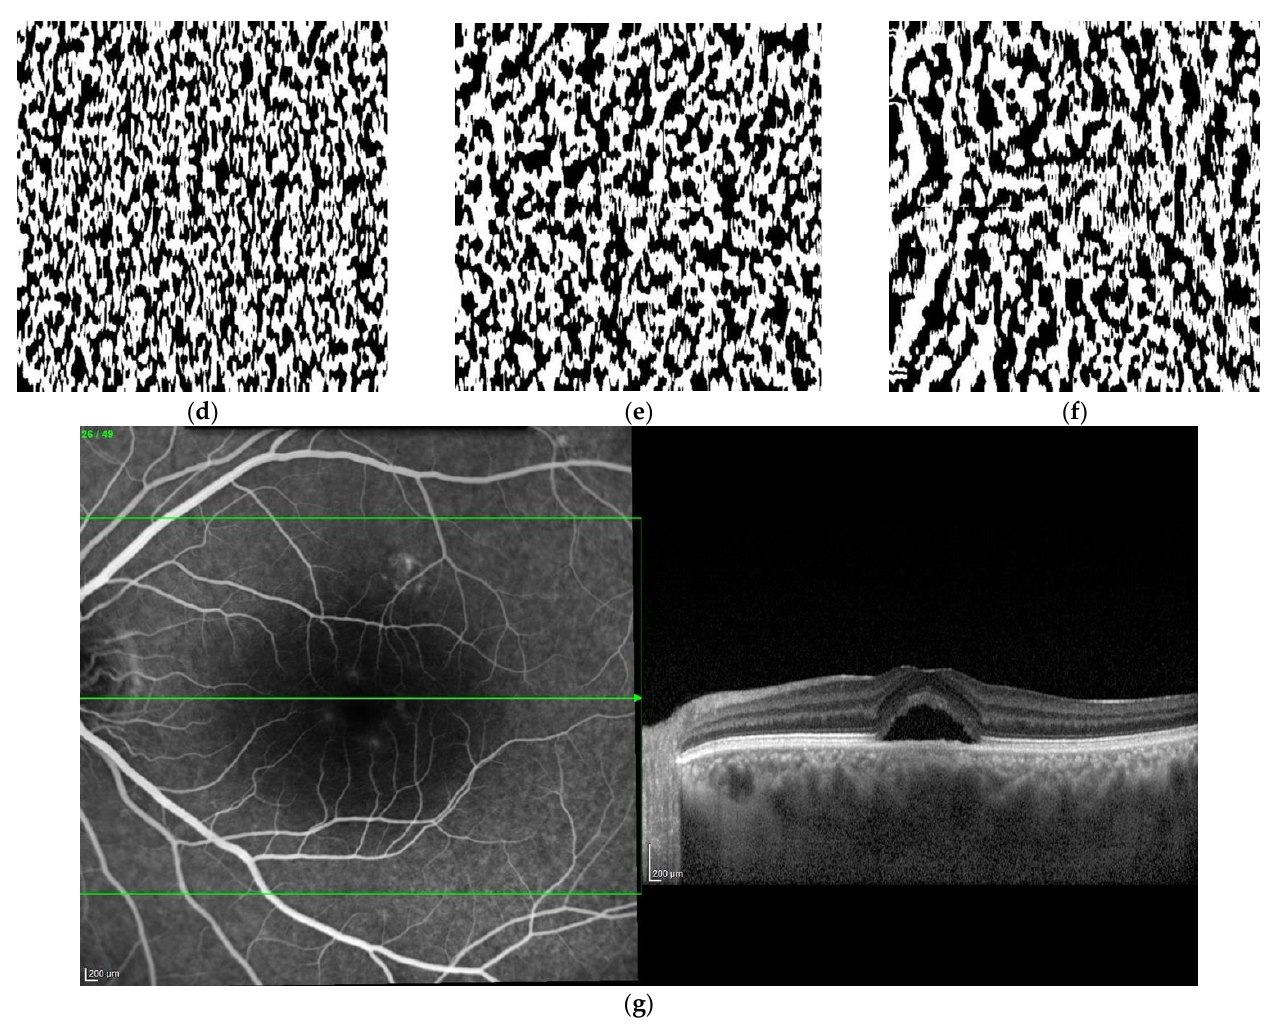
Figure 1. Original en face optical coherence tomography (OCT) scans and the software-processed images of an affected eye of a patient with central serous chorioretinopathy. Original en face OCT scan images of the superficial ( a ), medium ( b ) and deep ( c ) choroidal layer; binarized images of the superficial ( d ), medium ( e ) and deep ( f ) choroidal layer; OCT B-scan across the foveal center ( g ).